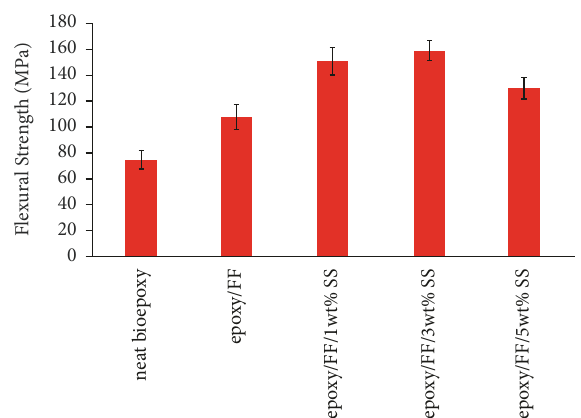
Figure 6: Flexural strength of pristine biobased epoxy and bio- based epoxy reinforced by FF and various weight fractions of